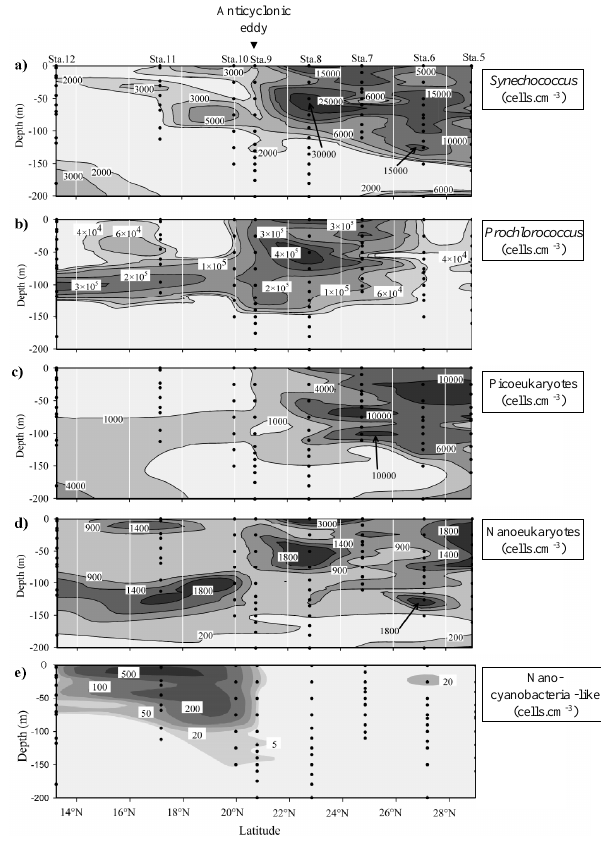
Fig. 9. Vertical abundances (cellscm − 3 ) of the five ultraphyto- plankton groups defined during the cruise: (a) Synechococcus , (b) Prochlorococcus , (c) picoeukaryotes and (d) nanoeukaryotes and (e) nanocyanobacteria. Black dots illustrate the sampling depth be- tween stations 5 and 12.